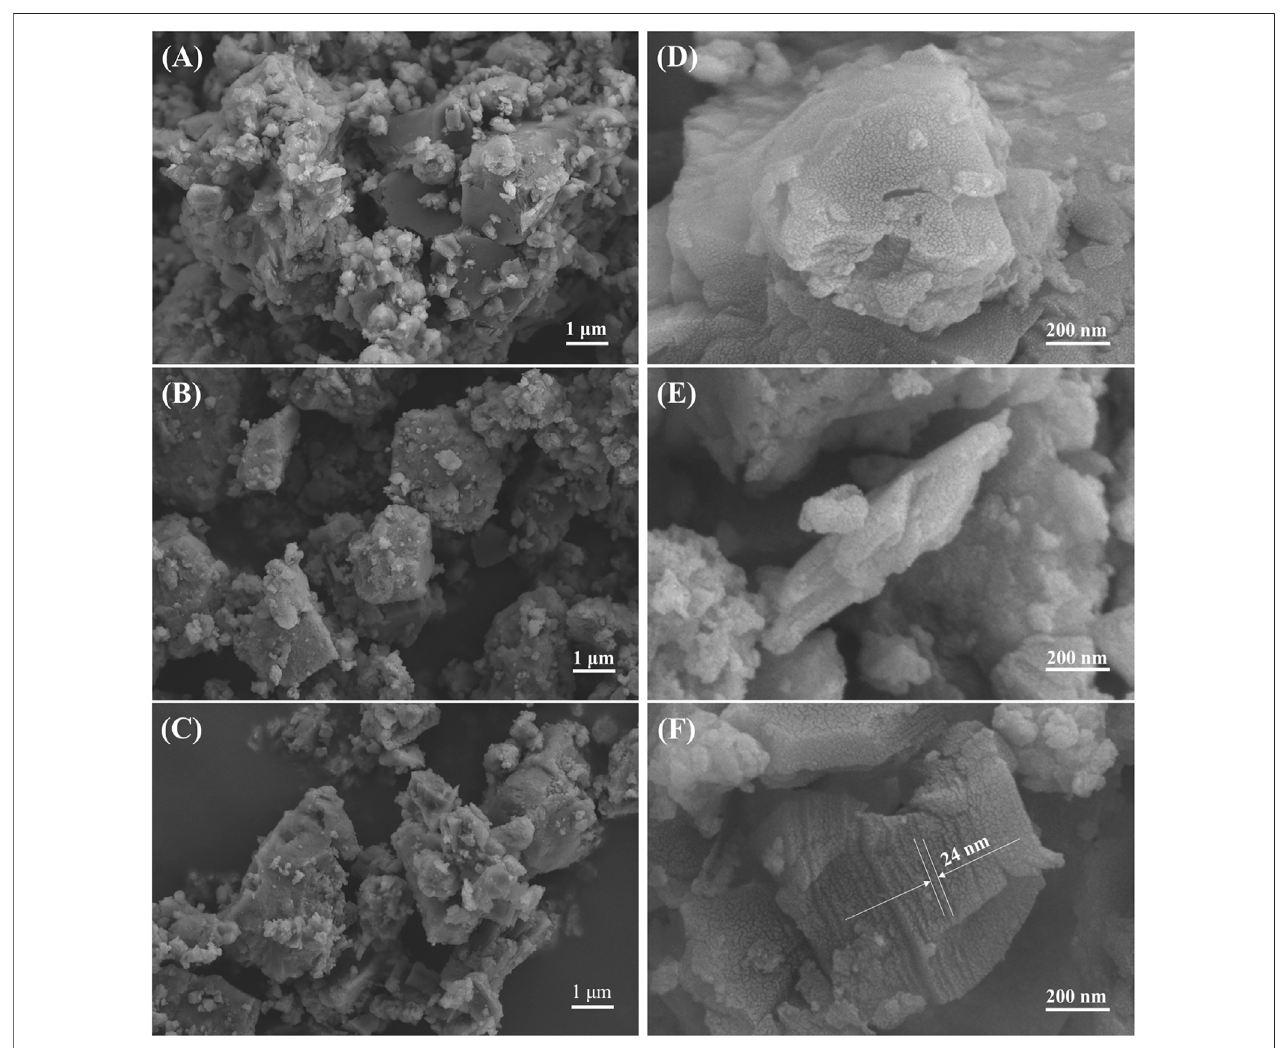
FIGURE 2 | SEM images of the (A,D) control, (B,E) NA-1, and (C,F) NA-2 samples.